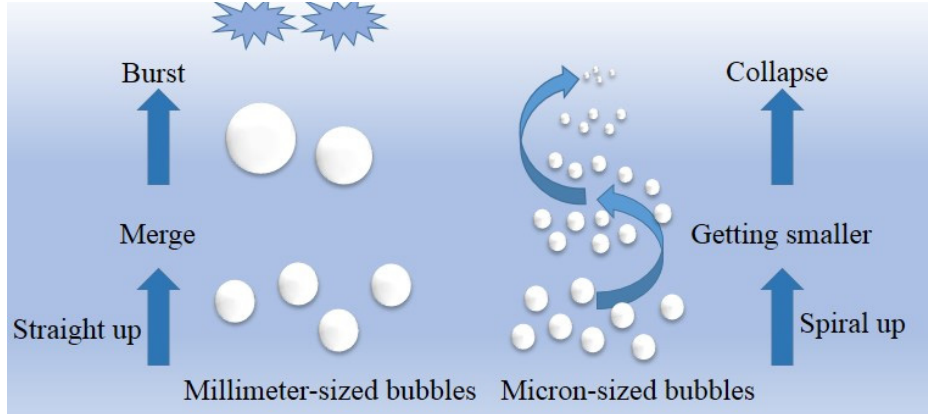
Figure 8. Comparison of millimeter-sized bubbles and micron-sized bubbles in water.